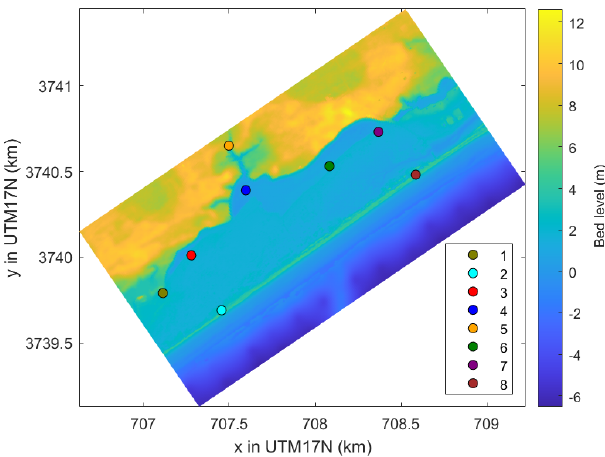
Figure 22. Bed level data for original non-extended domain of the Myrtle Beach test case with locations of interest marked with a cir- cle. The locations are colour-coded, and these colours are used to represent them throughout this section. Note that x and y are the Universal Transverse Mercator (UTM) coordinates for the global zone that Myrtle Beach is located in